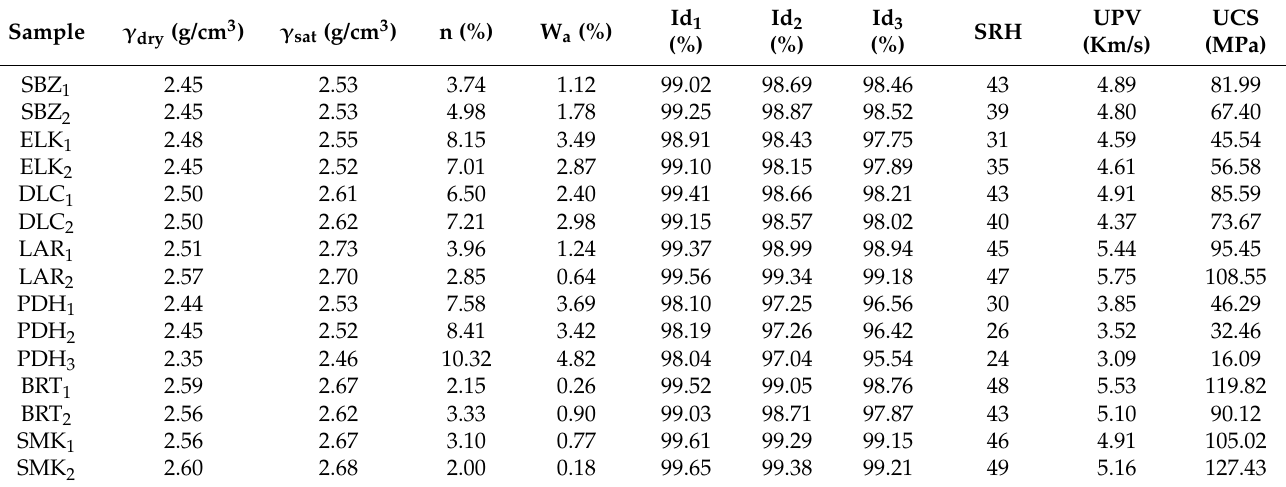
Table 2. Values of engineering properties of the tested rock